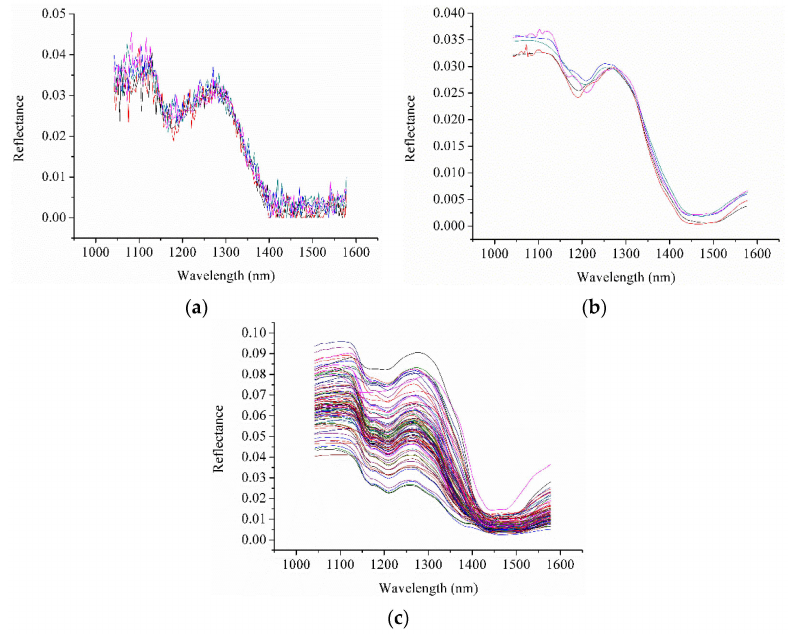
Figure 1. The unpreprocessed of spectra of ( a ) five randomly selected pixels; ( b ) the spectra of the five pixels preprocessed by WT; and ( c ) the average spectra of each